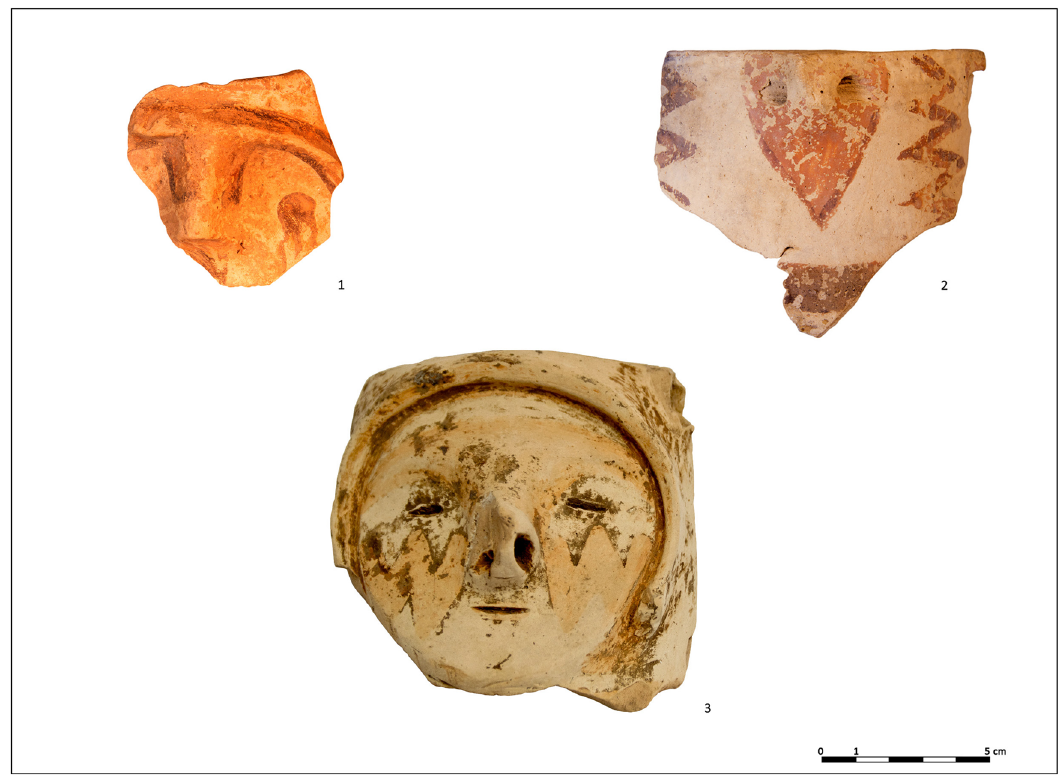
Figure 4: Anthropomorphic vessels in the Scaloria Style from Cavity A ( 1 ) , Cavity E ( 2 ) and Tunnel connecting Cavities D and E ( 3 ) of Grotta dei